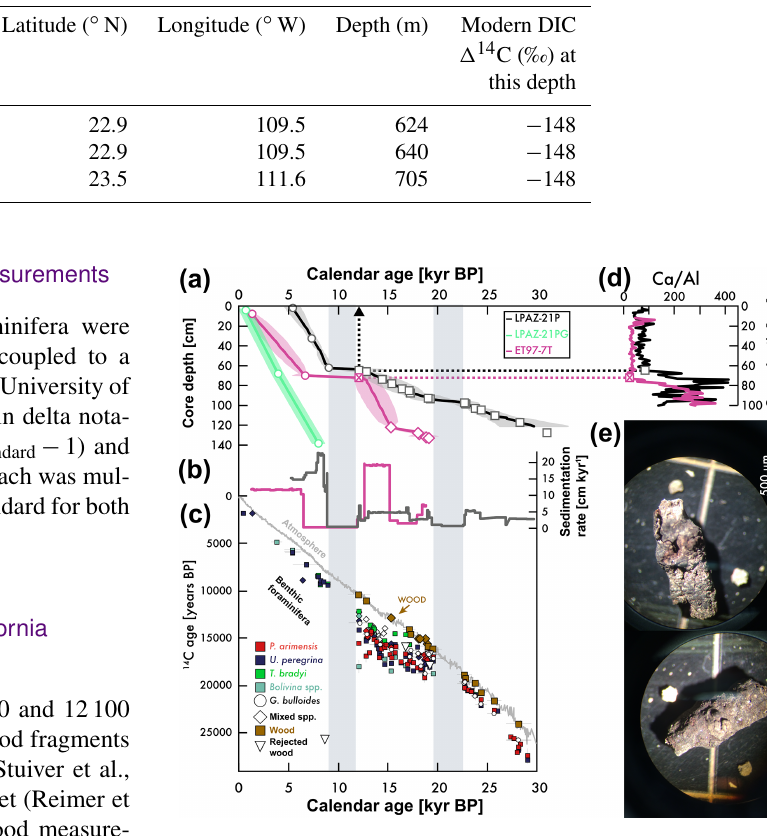
Figure 3. (a) Sediment core depth versus calendar age. Age model constraints are based on wood 14 C (squares and diamonds), strati- graphic correlation (X; see d ), and U. peregrina 14 C corrected for reservoir age (circles). (b) Sedimentation rate versus calendar age. (c) The 14 C age of atmospheric CO 2 , foraminifera, wood, and re- jected wood (see legend) versus calendar age for ET97-7T (dia- monds) and LPAZ-21P/LPAZ-21PG (squares). See Fig. 1 and Ta- ble 1 for locations. (d) Ca / Al for ET97-7T (pink) and LPAZ-21P (black) was measured using X-ray fluorescence (see “Materials and methods” section). Lower Ca / Al for the uppermost sediment (be- ginning at the arrows) is coincident with loss of calcium carbon- ate microfossils and an overall darkening of sediments at these and other sites in the region (van Geen et al., 2003). We use this strati- graphic feature to tie the age model for both sites (dashed arrow between the X symbols). (e) Examples of wood found within sedi- ment core LPAZ-21P (see